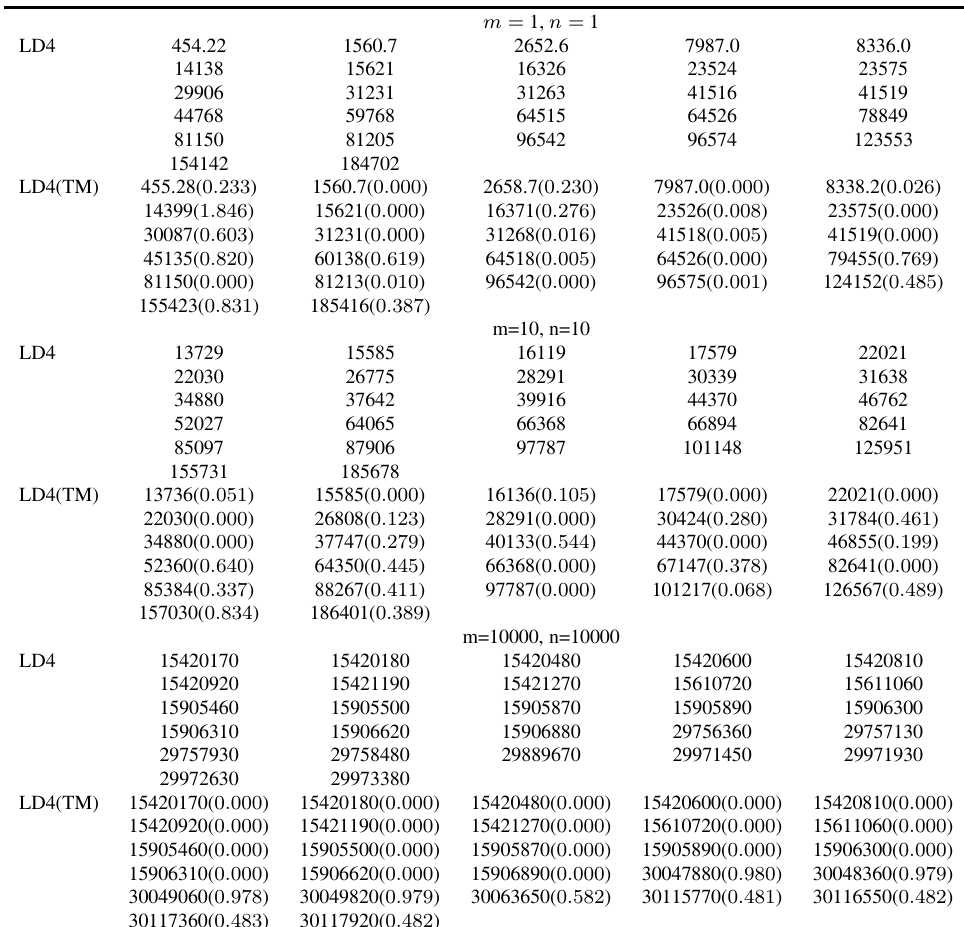
Table 9 Free vibrations of two-layered isotropic shell: higher-order frequency values f in Hz . Thickness ratio R α /h =